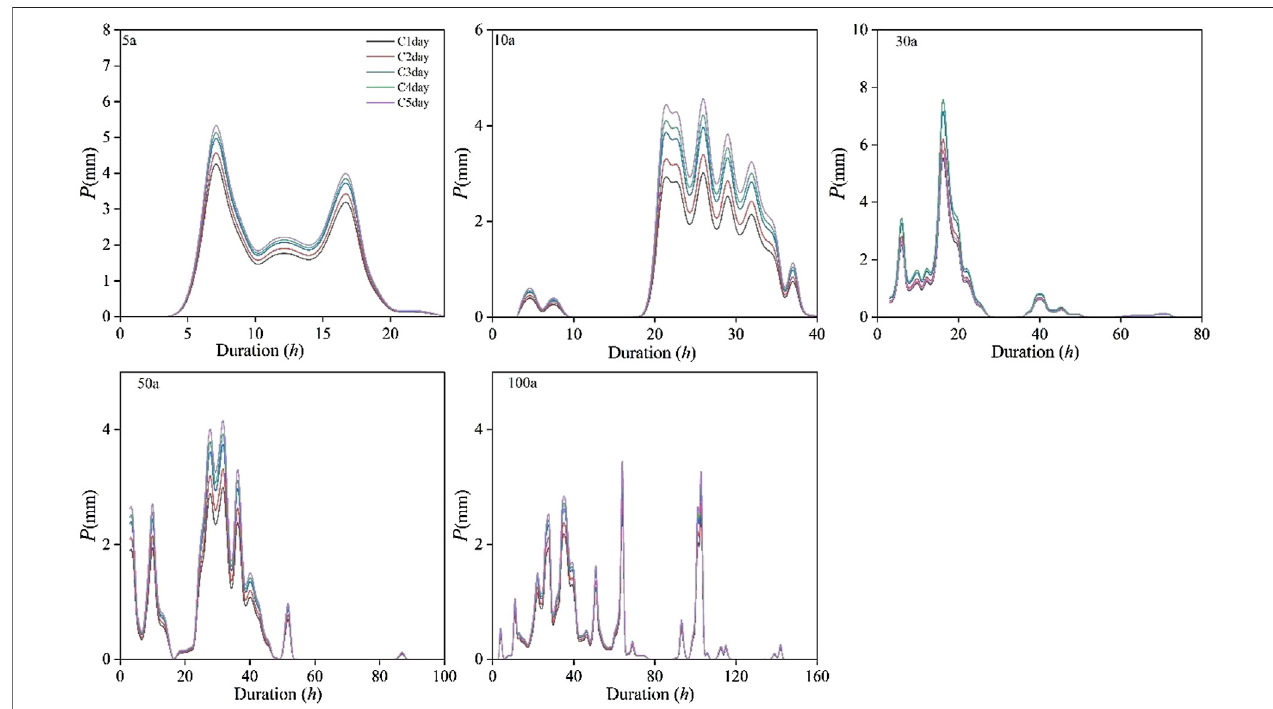
FIGURE 11 | Rainfall process under different duration and different return periods.